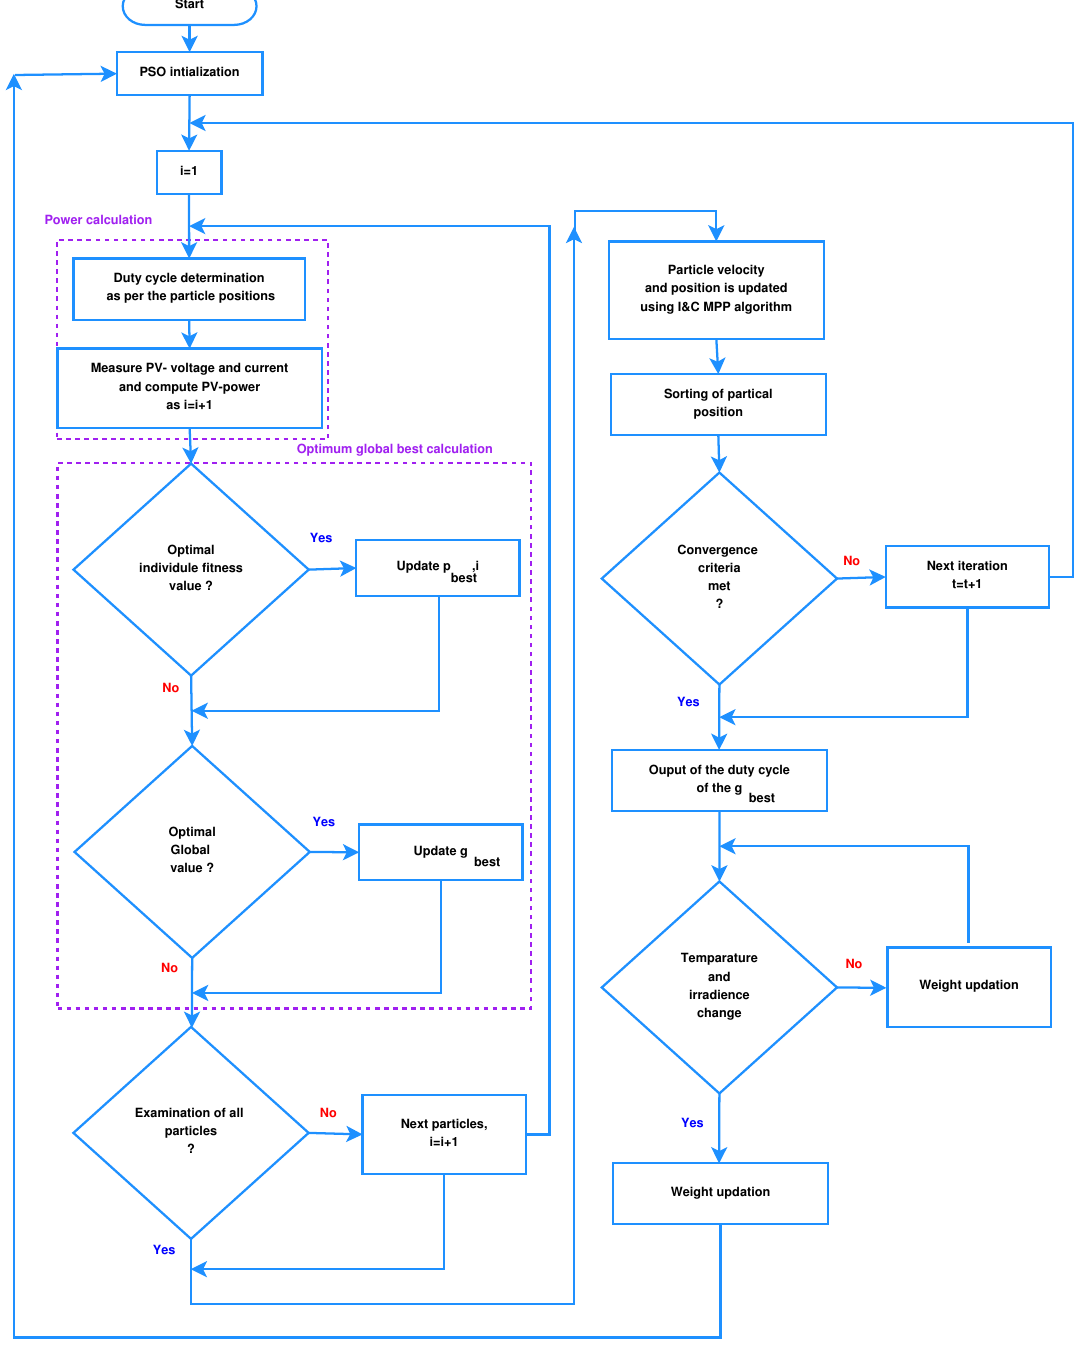
Figure 5. Proposed ICPSO